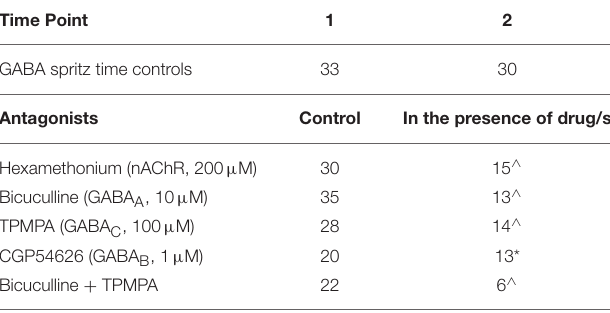
TABLE 2 | Number of neurons responding to GABA in control conditions and in the presence of